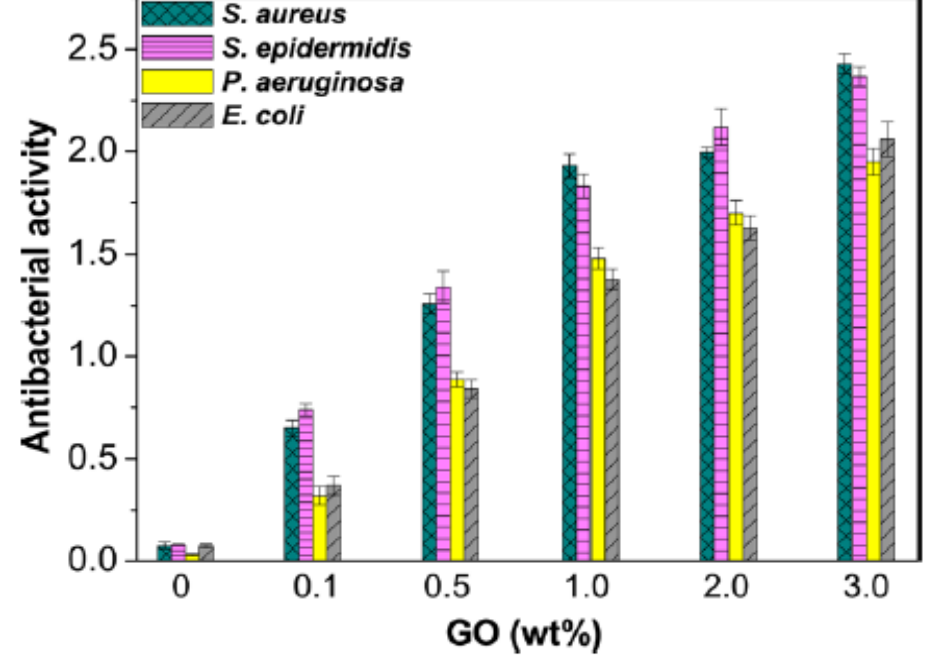
Figure 6. Antibacterial action of PPF/PEG-GO nanocomposites with different GO loadings against S. aureus, S. epidermidis, P. aeruginosa , and E. coli . Taken from Ref. [13]. S. aureus, S. epidermidis, P. aeruginosa , and E. coli . Taken from Ref.